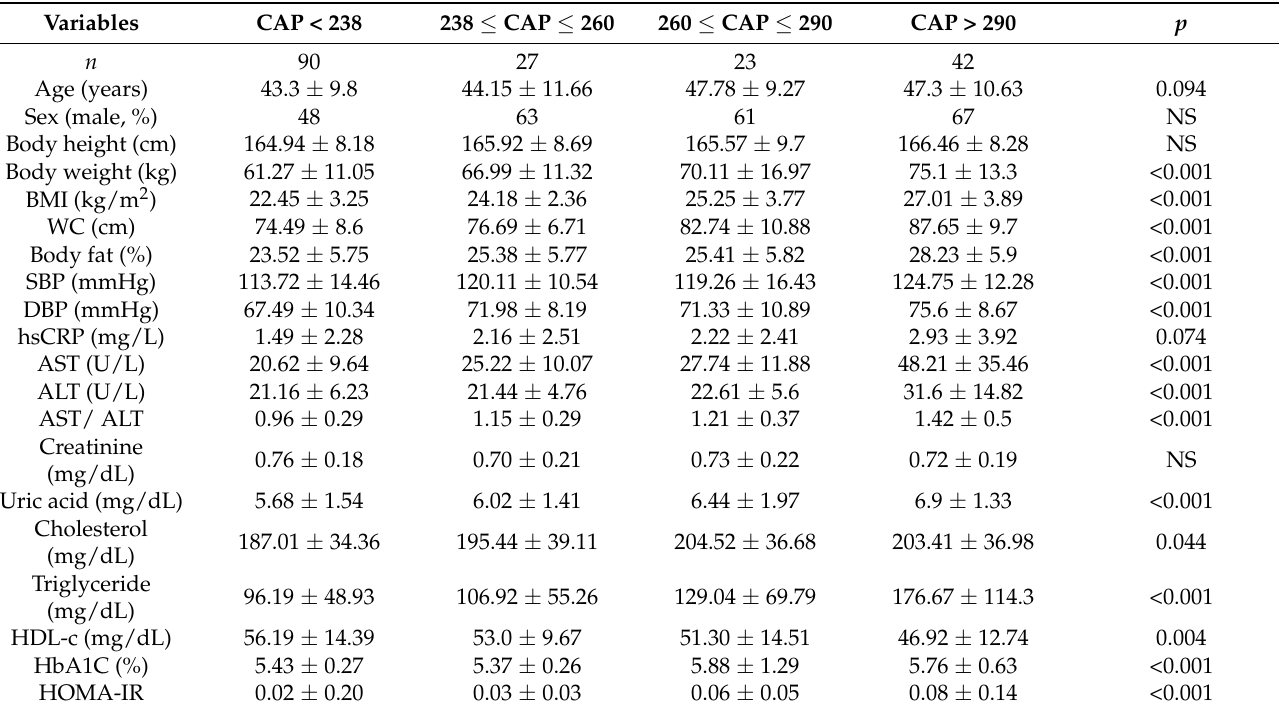
Table 1. Clinical characteristics of the enrolled study